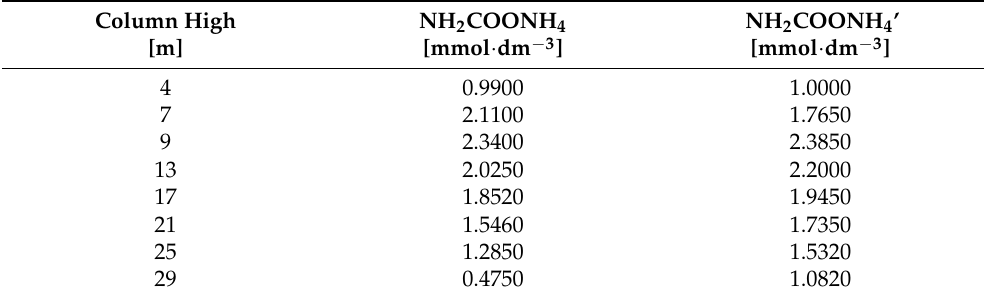
Table 2. Ammonium carbamate concentration (equilibrium and non-equilibrium) along the car- bonization column.